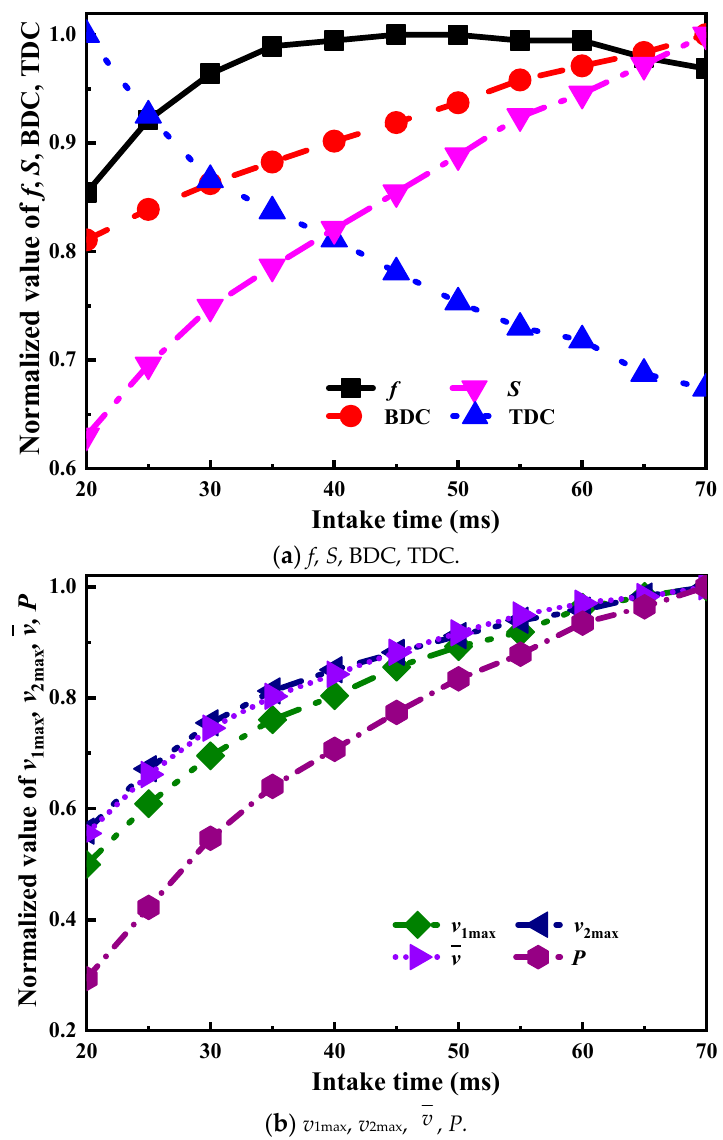
Figure 13. Variation of performance parameters with intake time.